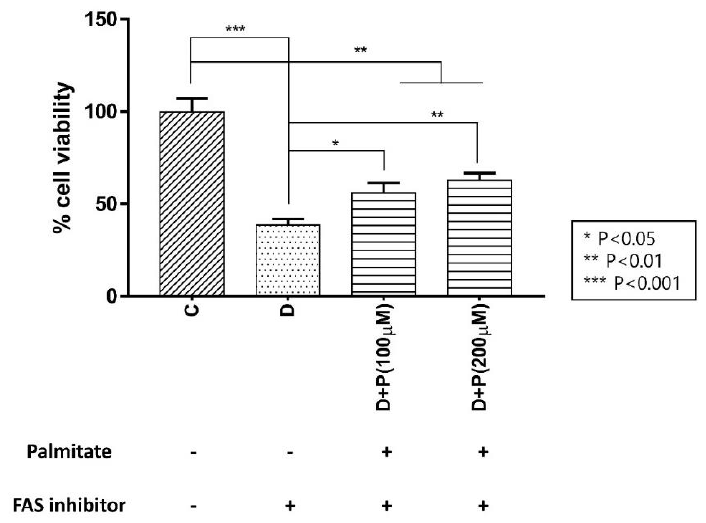
Figure 4. Effect of extracellular palmitate during FAS inhibitor treatment on LNCaP-LN3 human prostate cancer cell viability. (C: control group, D: TVB-3166 group, D + P(100 μM): TVB-3166 with 100 μM palmitate, D + P (200 μM): TVB-3166 with 200 μM palmitate).